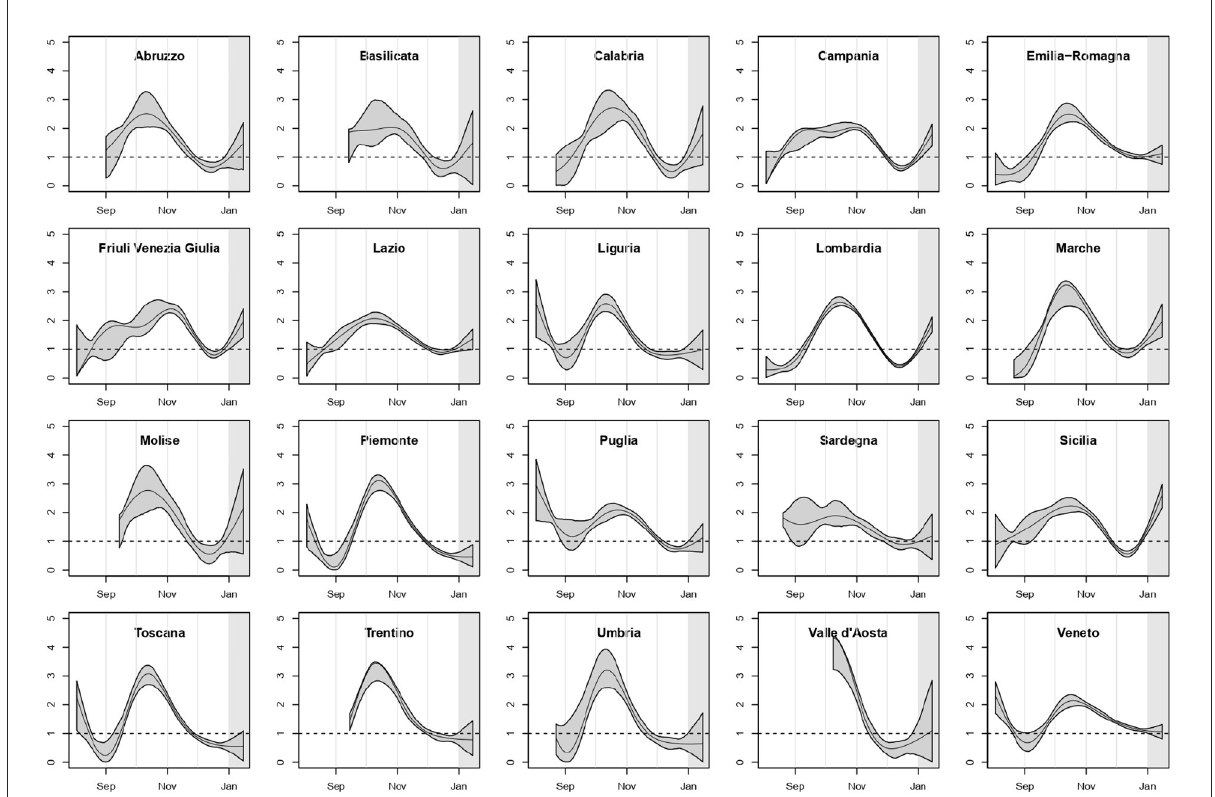
FIGURE1 Estimated R 0 ( t ) with point-wise 90 % confidence bands, by region; p = 1.15 % , T = 14 days.